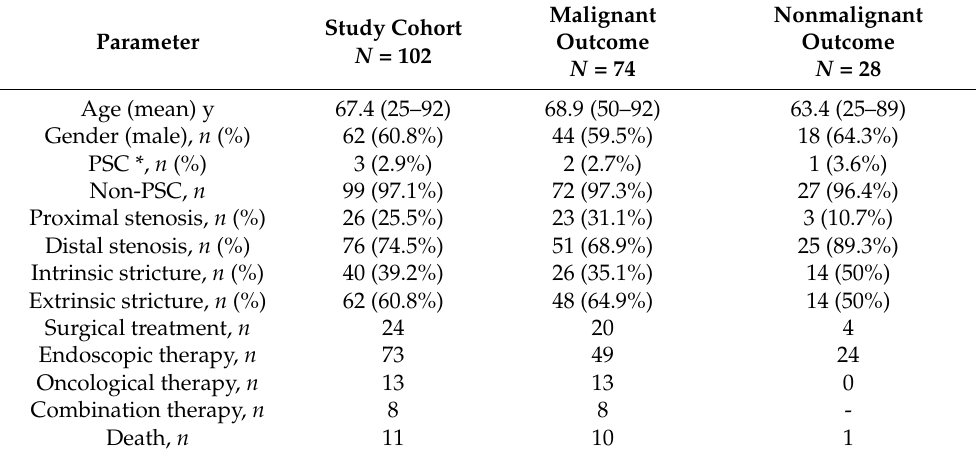
Table 1. Patient